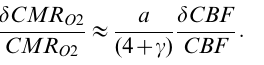
Table S2 Cerebral capillary and neural characteristics in